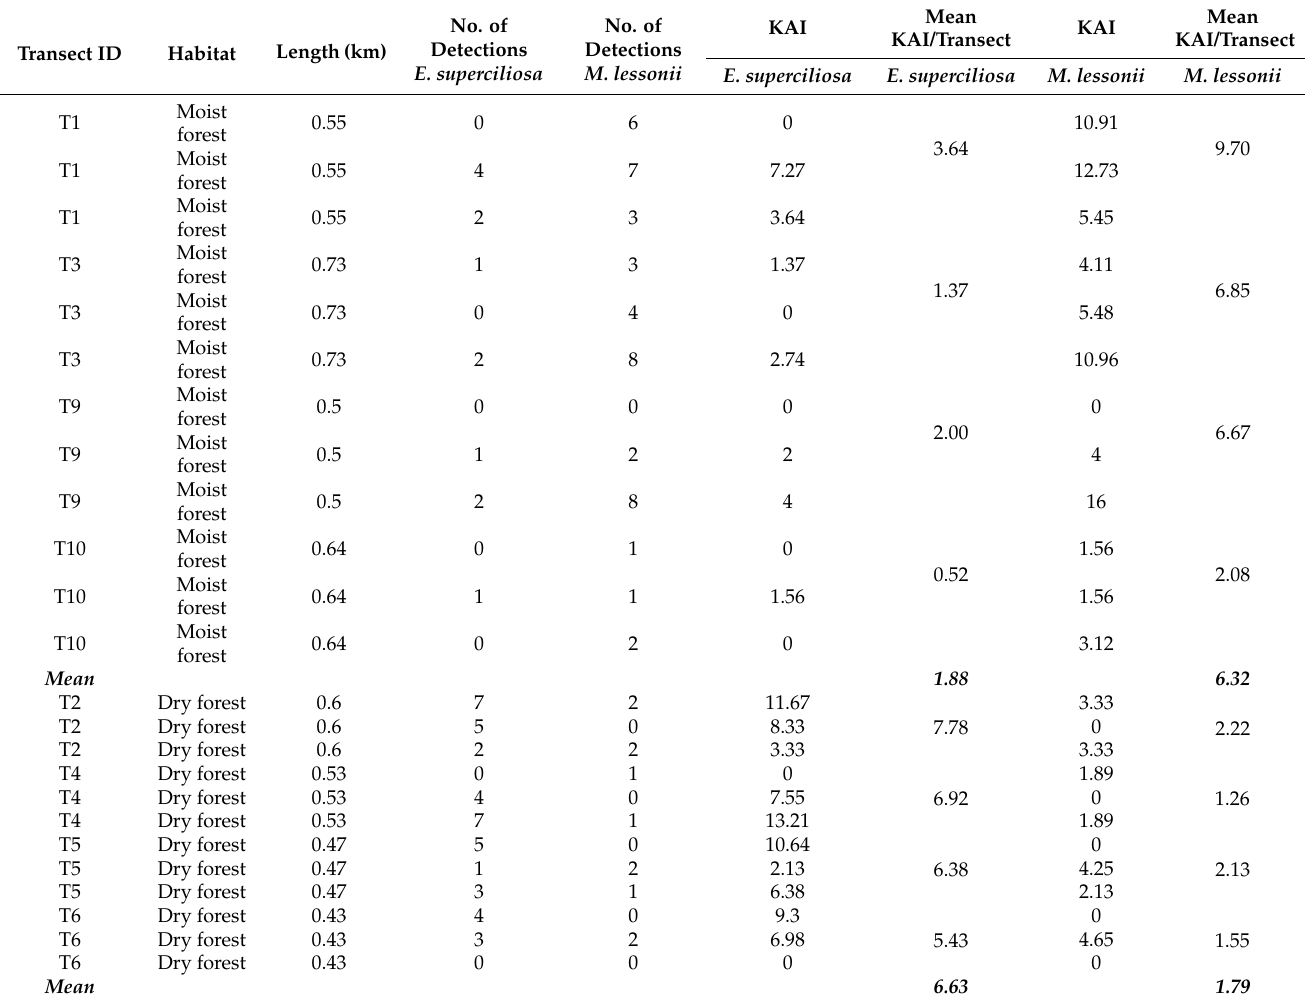
Table 2. Habitat and length of each transect, number of Eumomota superciliosa and Momotus lessonii observations, and Kilometric Abundance Index (KAI) for the two species along each transect